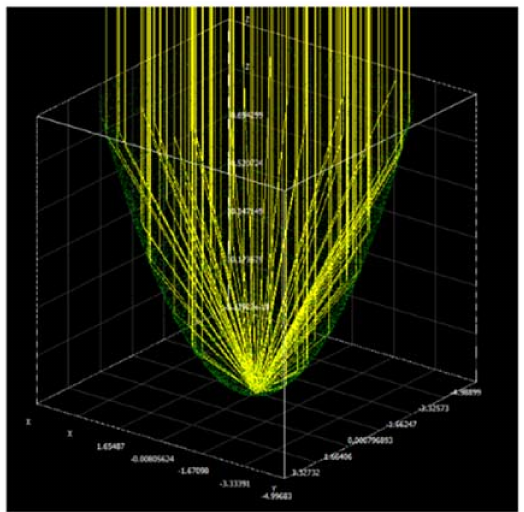
Figure 13. Soltrace simulation. Solar ray’s interaction with a parabolic